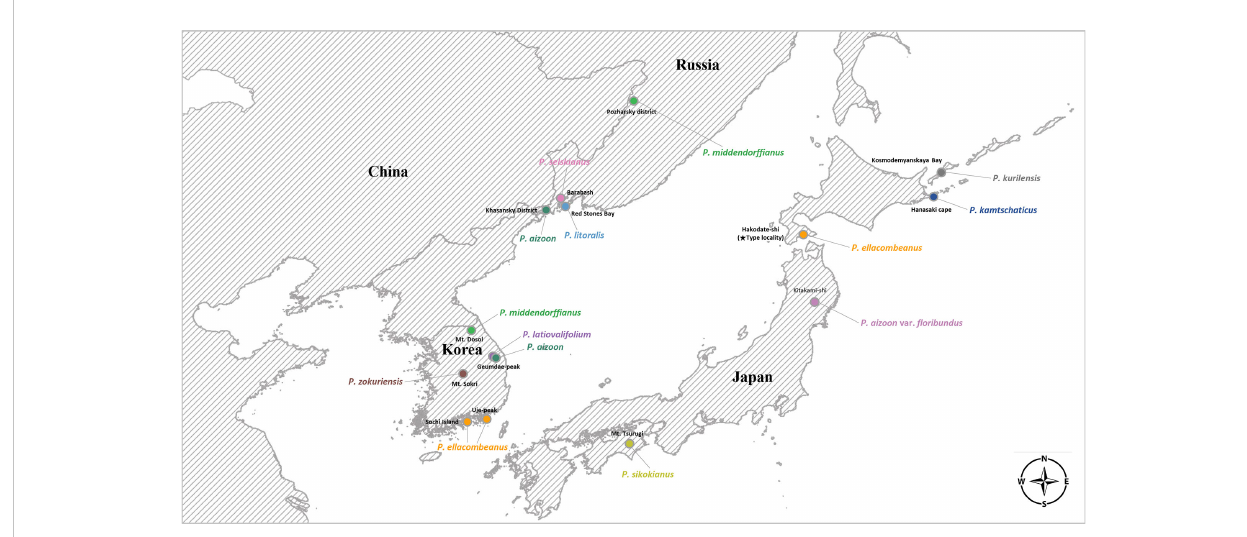
FIGURE 1 Distribution map of Phedimus species sampled in this